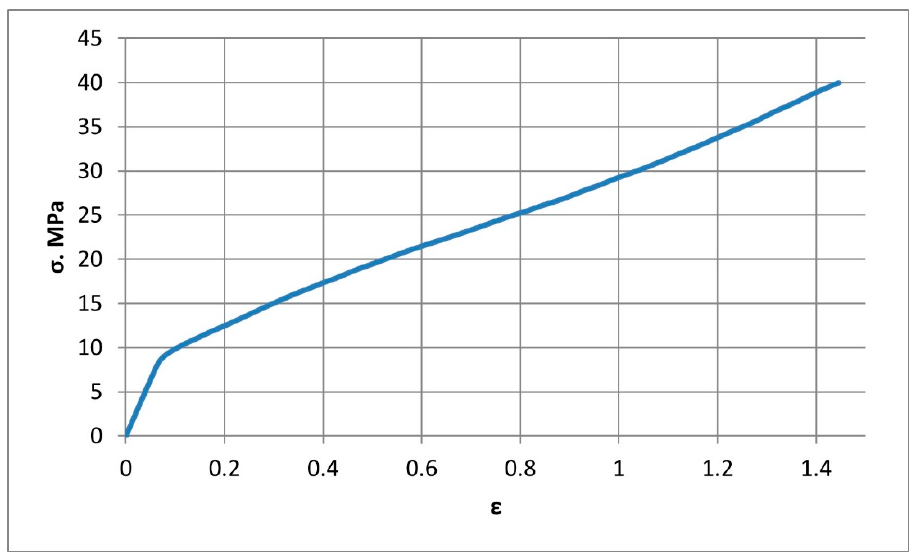
Figure 3. The true stress–strain curve for industrial PTFE at 25 ° С , provided that the speed of linear elongation deformations does not exceed 500 μ m/s.